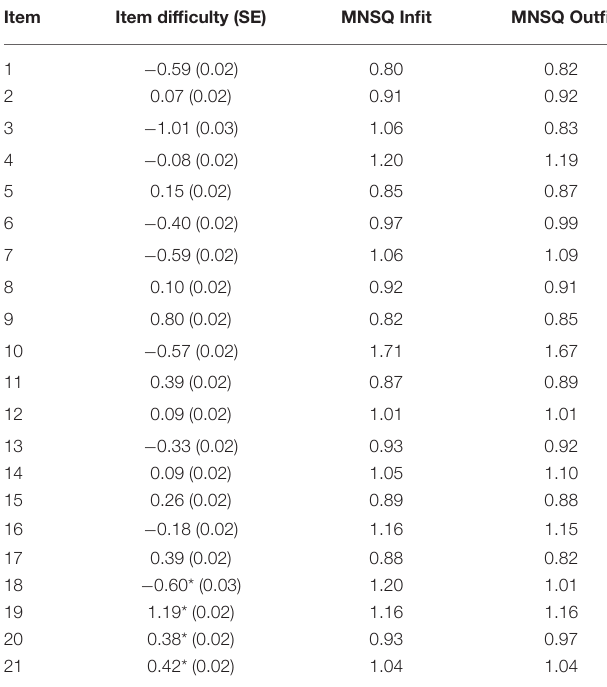
TABLE 7 | Item difficulty measures, standard errors, infit and outfit mean squares, differential item functioning between males and females. Item